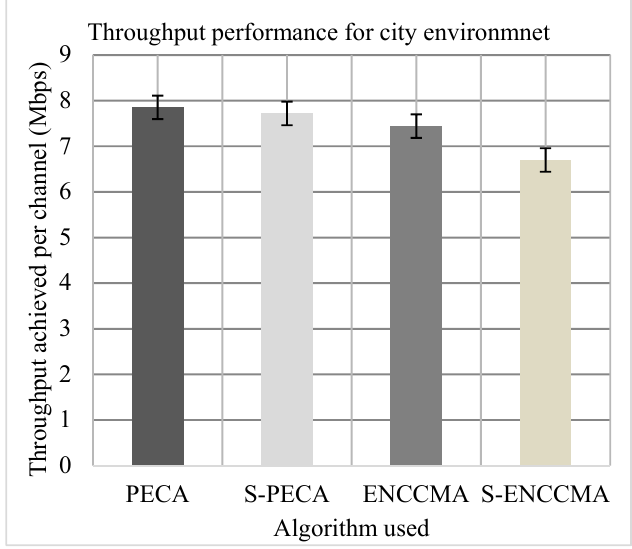
Figure 7. Throughput performance for the city environment. Throughput performance for highway environmnet